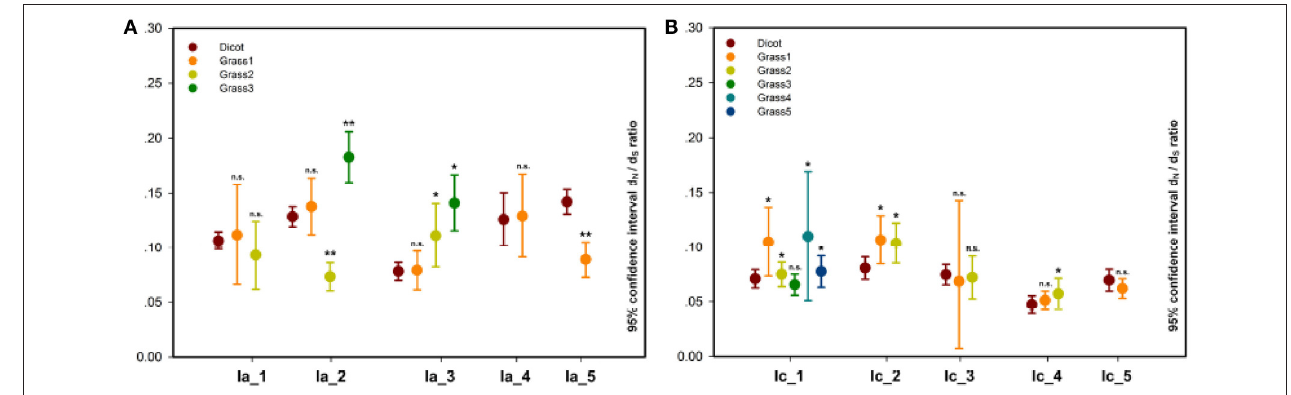
FIGURE 4 | Pairwise estimation of ω values in each dicot or grass subgroup within subfamilies. (A) Ia_1-5; (B) Ic_1-5. In each of the subfamilies, a significance test on the difference between dicot and grass subgroup was carried out, and its result, listed in Table S1, is indicated by n.s. (not significant), * P < 0.05, and ** P <